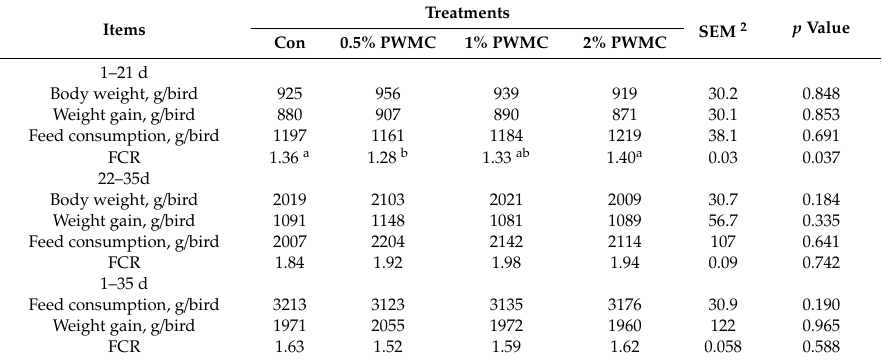
Table 4. The growth performance of 35-day-old broilers following dietary PWMC 1